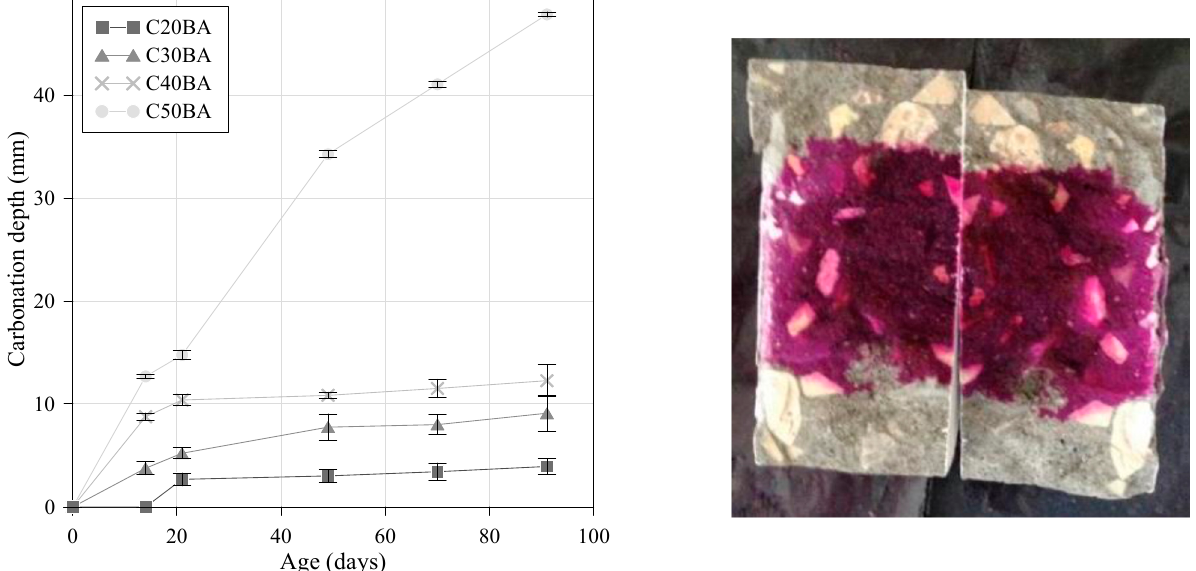
Figure 9. Carbonation depth ( left ) of samples with MIBA ( right ).